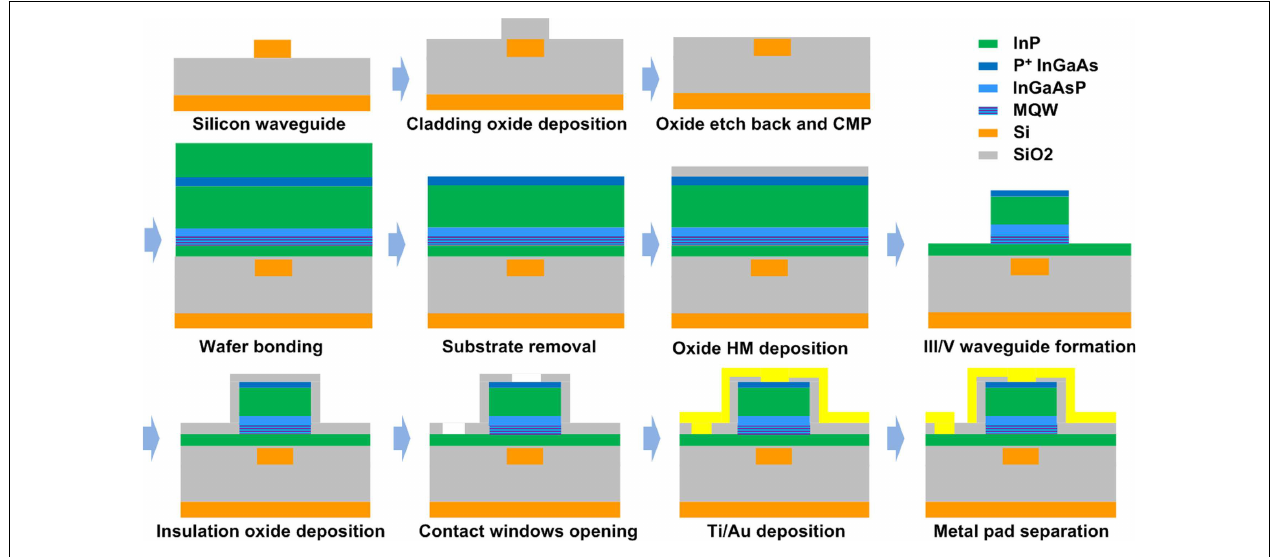
FIGURE 11 |The fabrication process of the hybrid silicon laser in a ridge waveguide structure